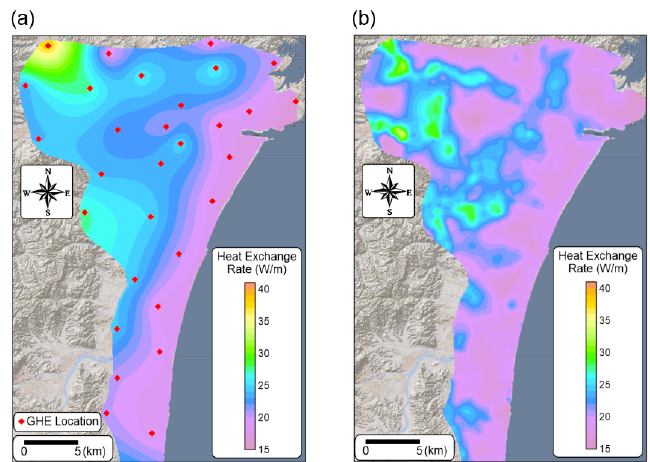
Figure 11. Comparison of ( a ) distribution map of heat exchange rates by Kaneko et al. [21]; conventional map with ( b ) that estimated by the RSM; refined map for the Sendai Plain. Energies 2019 , 12 , x FOR PEER REVIEW